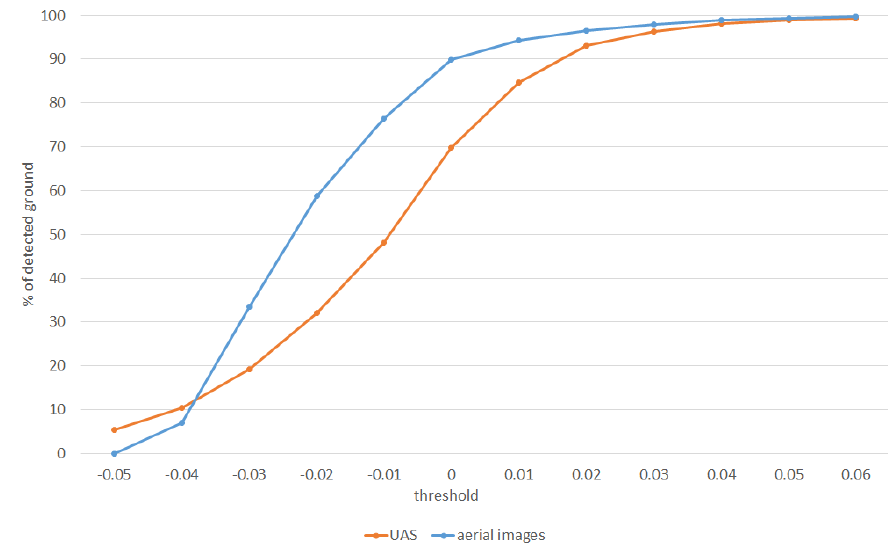
Figure 7. Curves showing the percentage of detected ground on the UAS (May 2017) and aerial (June 2015) images for the selected threshold values.